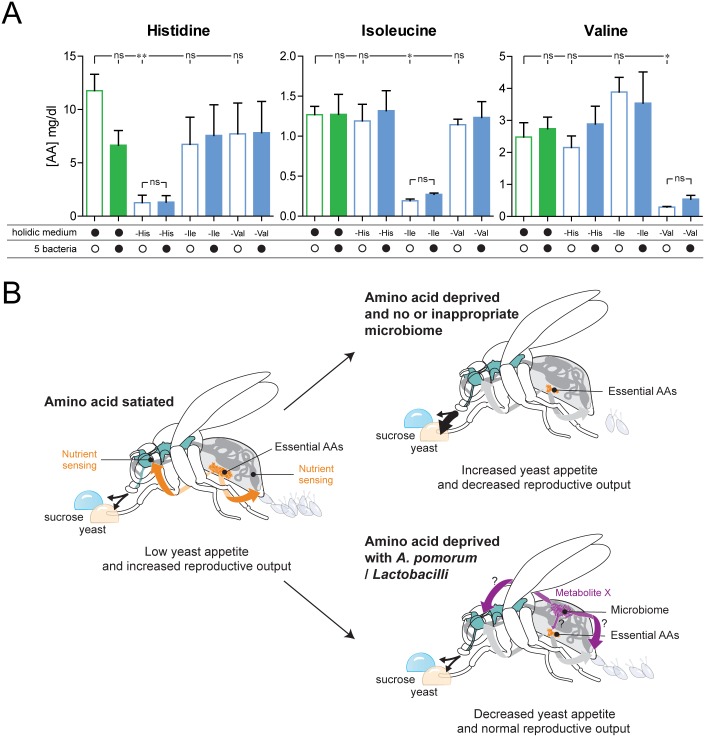
Commensal bacteria do not seem to change the levels of essential amino acids (eAAs) in the host.(A) Histidine (His), isoleucine (Ile), and valine (Val) concentrations in the heads of flies prefed on complete holidic medium (green) or holidic medium lacking His, Ile, or Val (blue), without (empty columns) or with (filled columns) commensals pretreatment. The columns represent the mean and the error bars the standard error of the mean of three independent experiments. Filled black circles represent complete holidic medium or pretreatment with the bacteria mix. Open black circles represent no pretreatment with bacteria mix. Amino acid (AA) deprivation is indicated as –histidine (–His), –isoleucine (–Ile), or –valine (–Val). Significance was tested using the unpaired t test with Bonferroni correction. Not significant (ns) p > 0.05, * p < 0.05, ** p < 0.01. (B) Model of the impact of eAAs on food choice and reproduction, depending on the presence of the microbiota of the host. The nervous system is highlighted in turquoise, AAs in orange, and commensal bacteria in purple. Arrow weight from the proboscis to the food drops indicate amount of feeding, and the number of eggs reflect the reproductive output. The orange and purple arrows indicate potential effects of eAAs and metabolites, respectively, at the level of the nervous and reproductive systems. Metabolite X refers to a hypothetical metabolite mimicking the presence of AAs. Underlying data used in this Fig are provided in S1 Data.